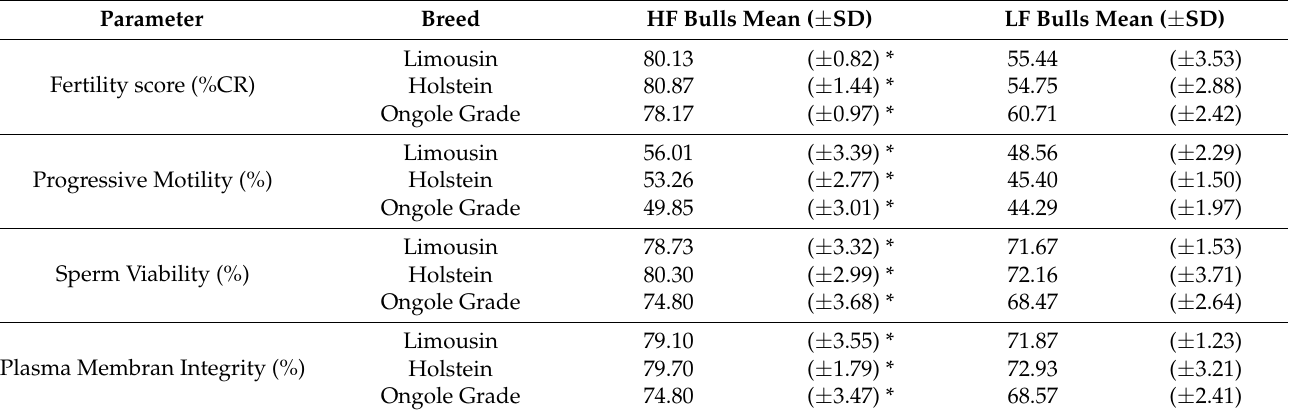
Table 1. The difference in the Limousin, Holstein, and Ongole Grade bulls mean parameters, with different fertility, HF vs. LF